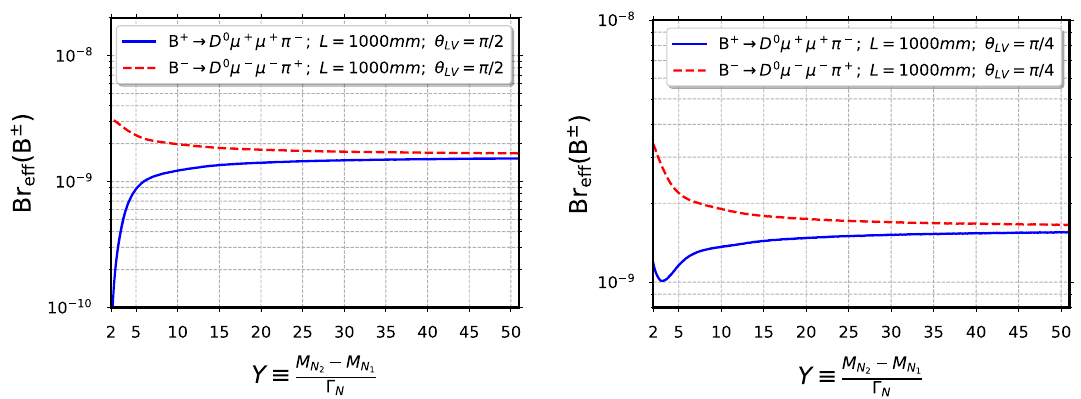
Fig. 5 Effective branching ratio as a function of Y for M N = 2 . 0 GeV, L = 1000 mm and | B μ N | 2 = | B τ N | 2 = 10 − 5 . Left Panel: θ LV = π/ 2. Right panel: θ LV = π/ 4